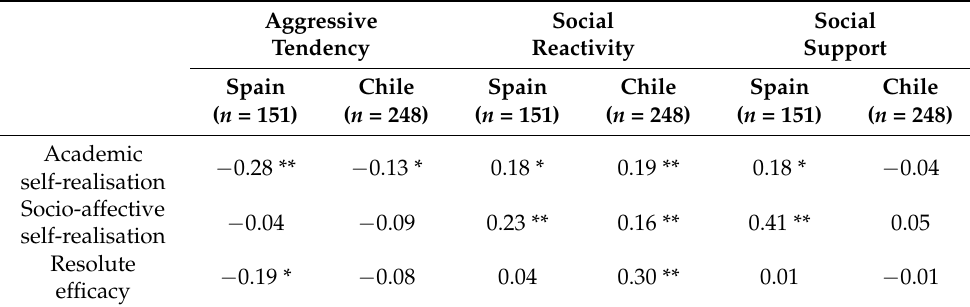
Table 7. Correlation between emotional behaviour and effective personality. Aggressive Tendency